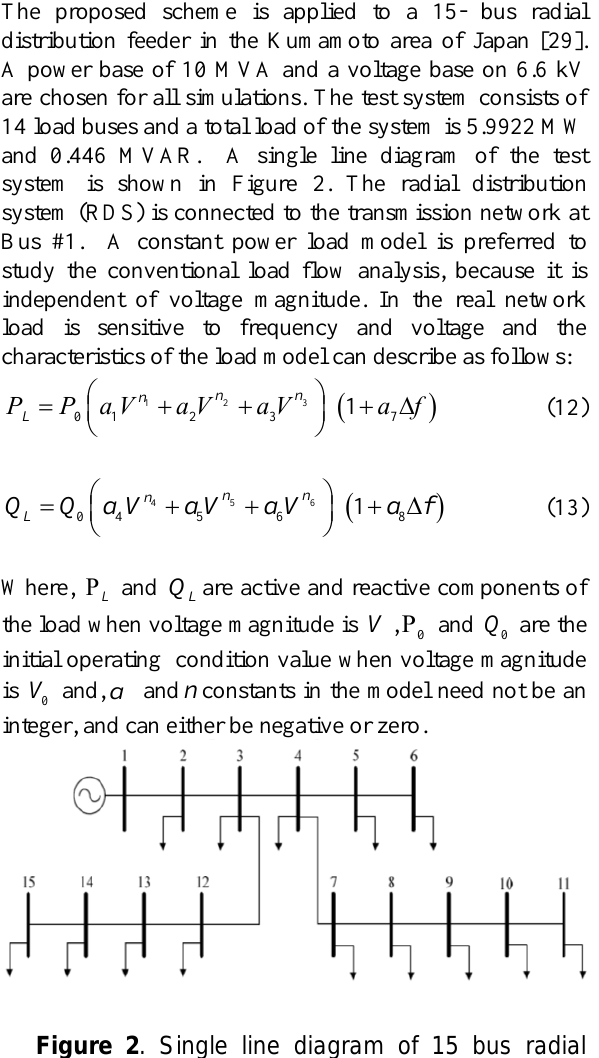
Figure 2 . Single line diagram of 15 bus radial